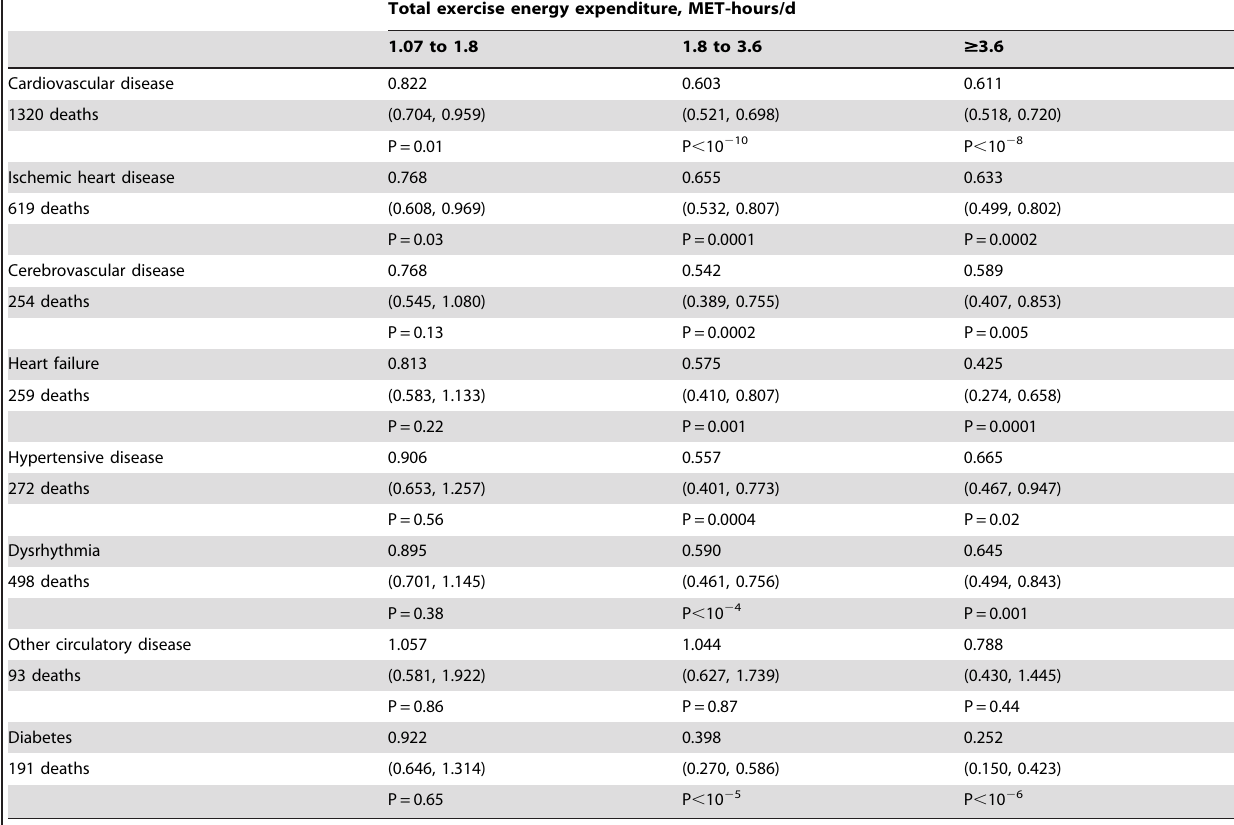
Total exercise energy expenditure,